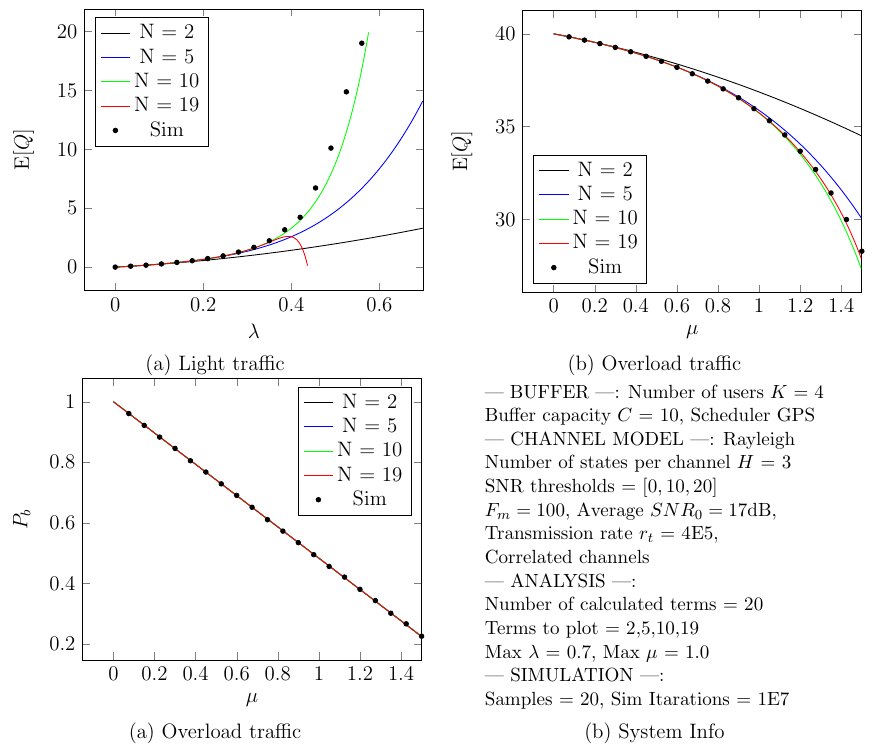
Figure 4: The output report generated by the